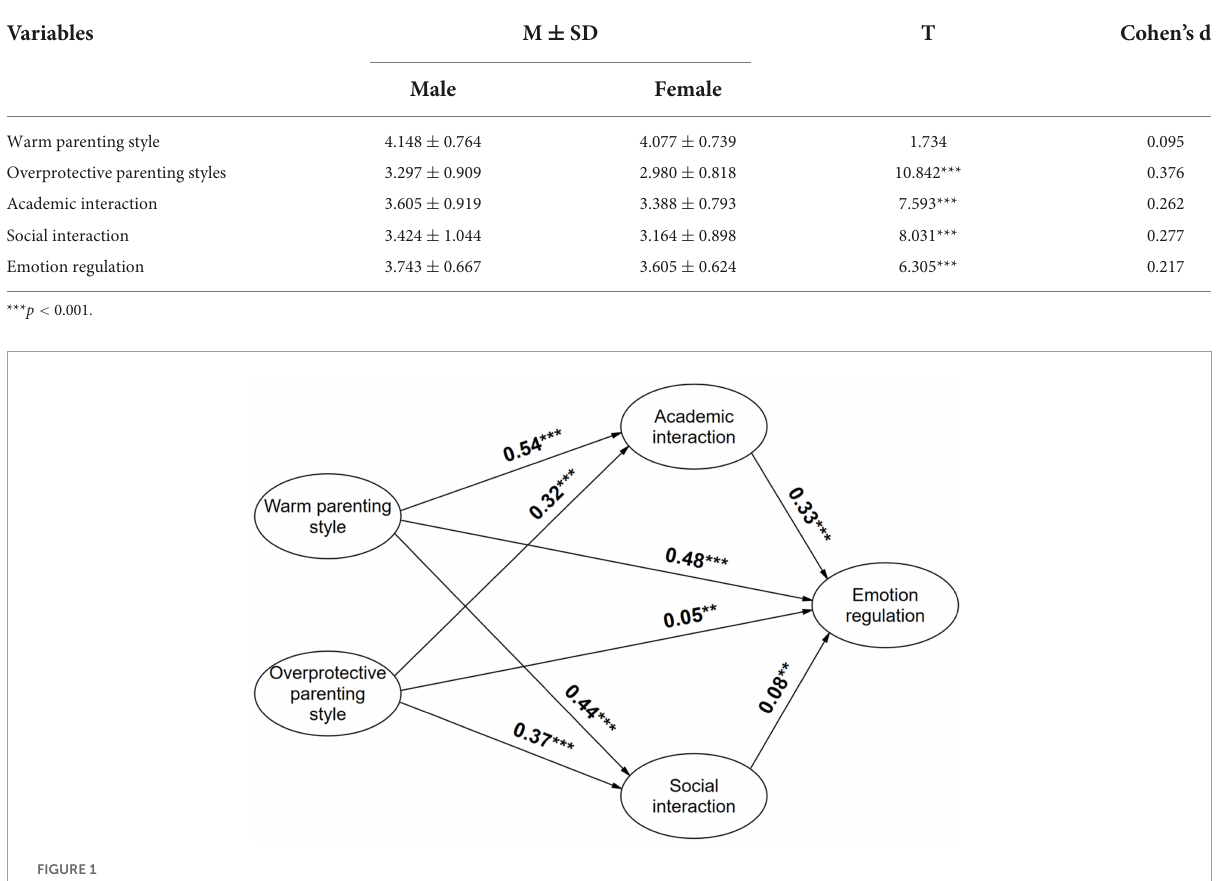
FIGURE1 Map of impact path coefficients. * p < 0.05; ** p < 0.01; *** p < 0.001.